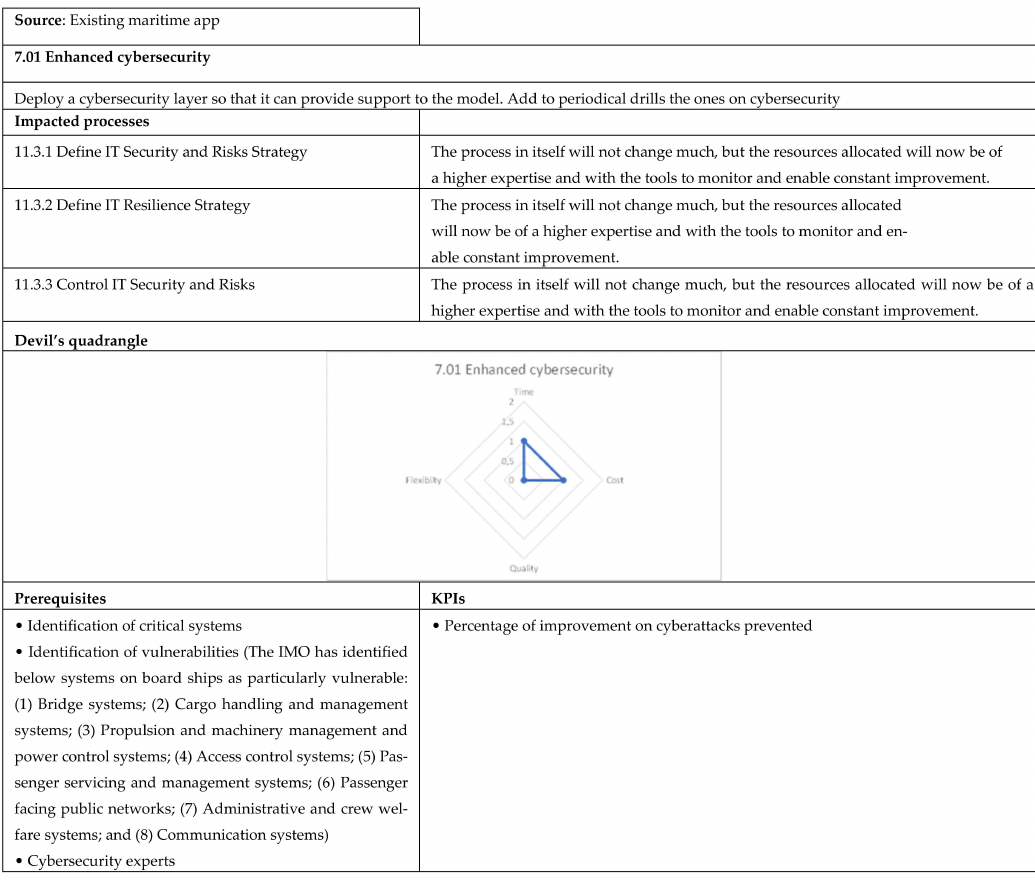
Figure A42. Enhanced cybersecurity data sheet.